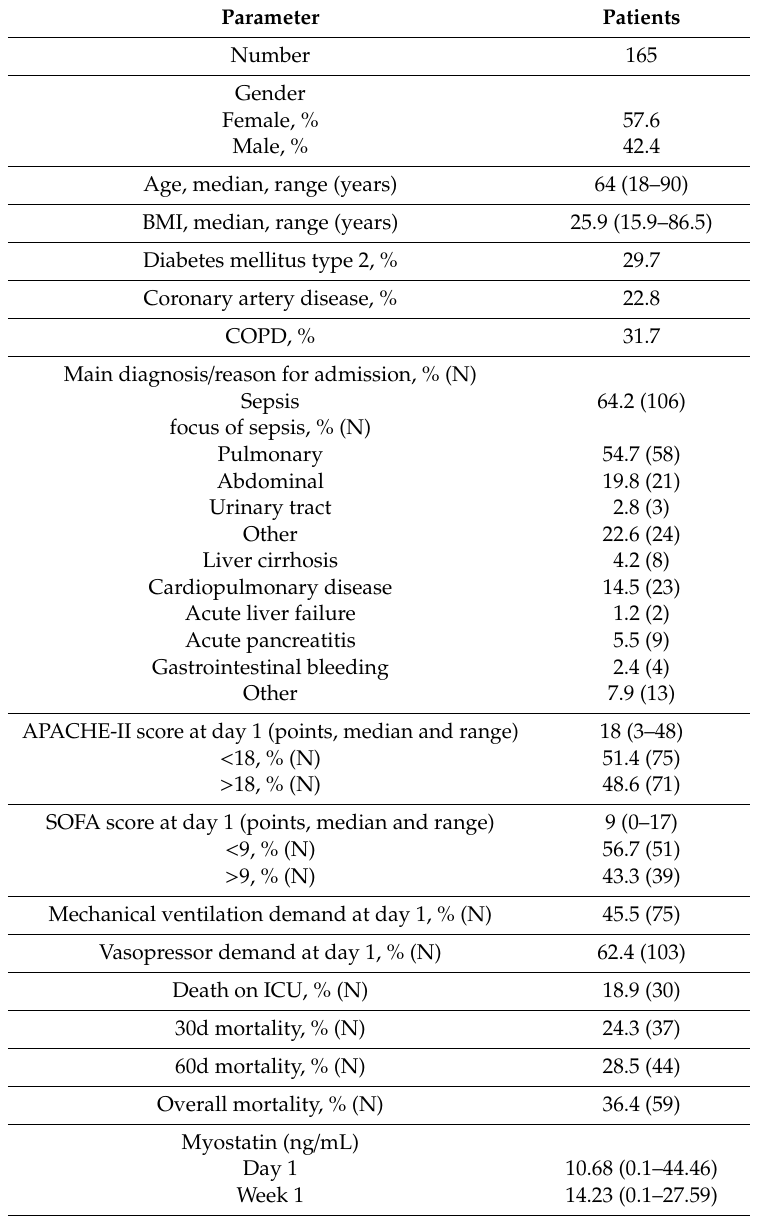
Table 1. Baseline patient characteristics at the time point of admission and Myostatin serum concentrations at days 1 and